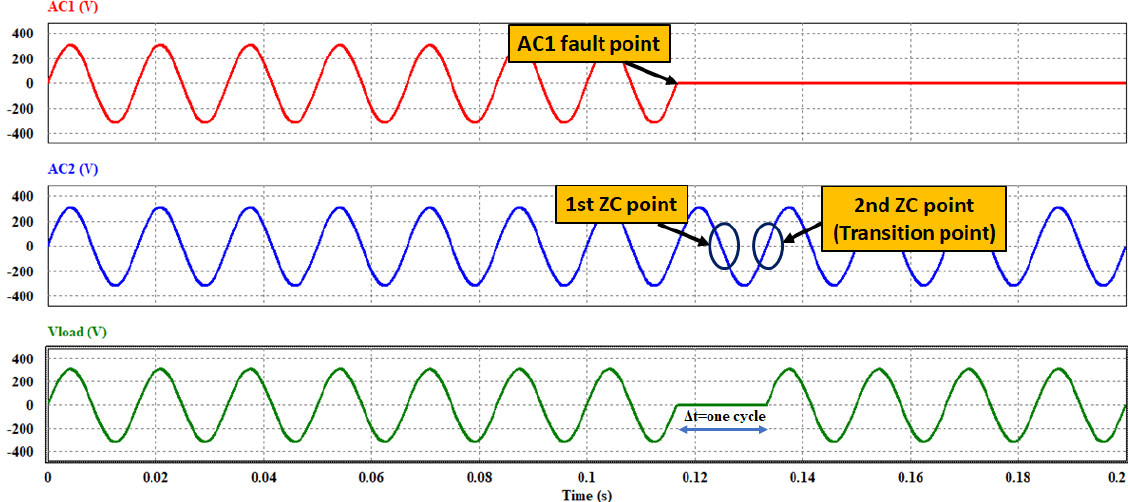
Figure 7. Supply and load voltage waveforms and the transition point of the proposed SSTS when the AC1 and AC2 sources are pure sine waves and the AC1 source is faulted at the zero-crossing point (worst case).